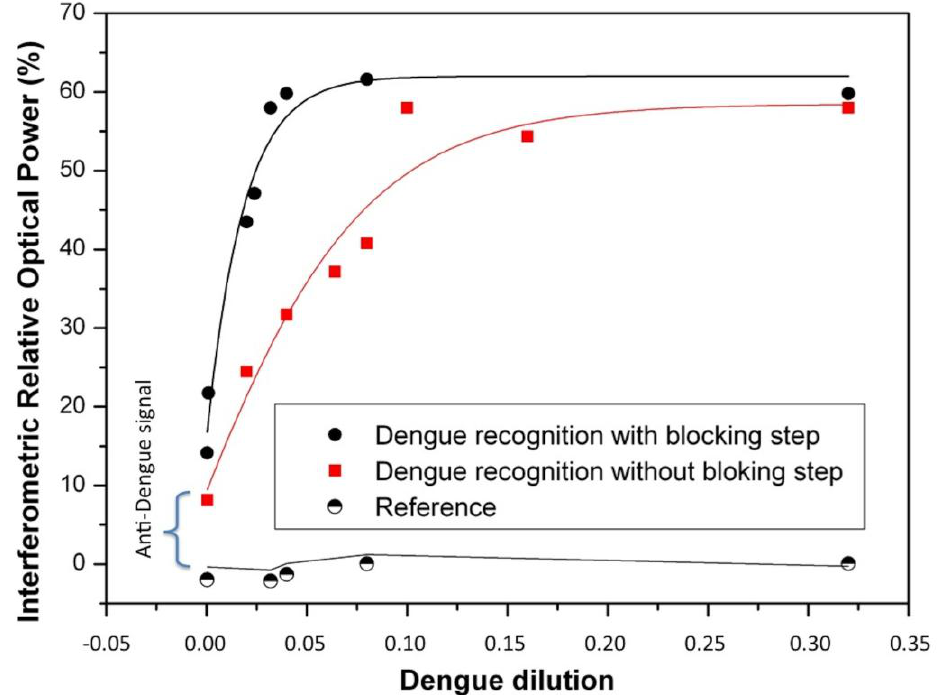
Figure 2. Comparison of sensing curves for dengue recognition with and without blocking step, where the skim milk reagent significantly improves the biosensing